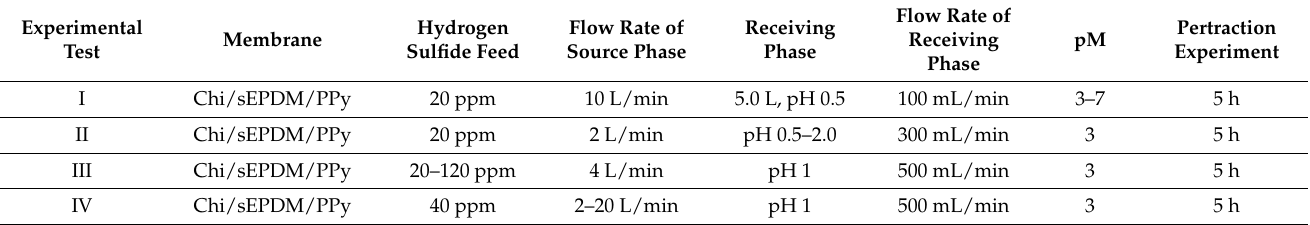
Table 3. Membrane system parameters used in the study of the H 2 S pertraction.